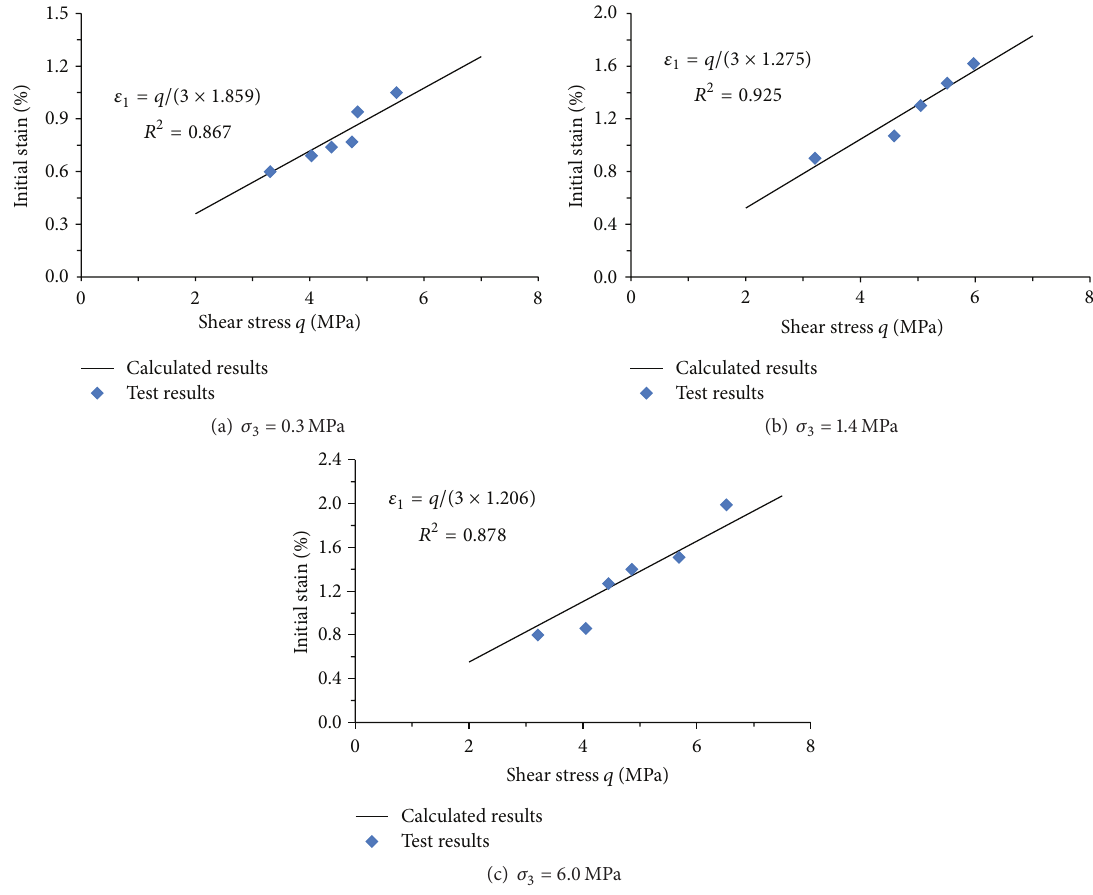
Figure 6: The initial elastic shear modulus under different confining pressures.